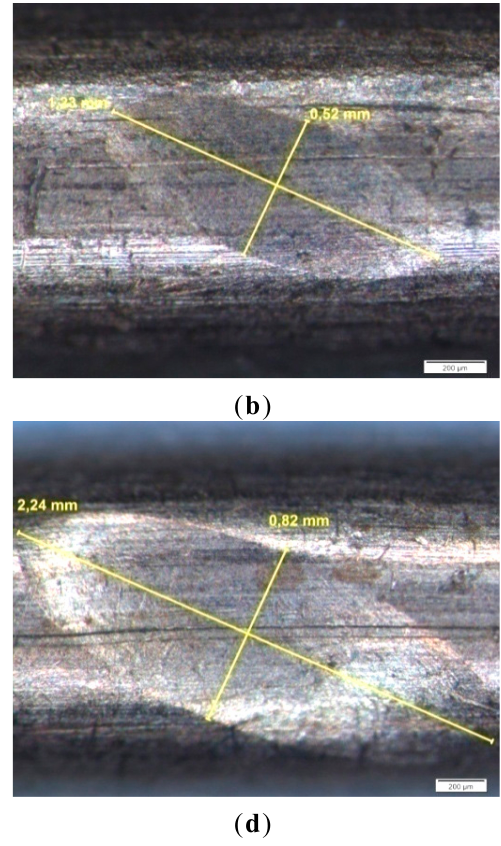
Figure 7. Residual imprints on the copper wire for a contacting angle of 45° under = 100 N, averaged stress =115 N/mm 2 ; ( b ) F ascending contact forces. ( a ) F C averaged stress = 99.5 N/mm 2 ; ( c ) F = 300 N, averaged stress = 90.4 N/mm 2 ; C ( d ) F = 480 N, averaged stress =83.2 N/mm 2 C